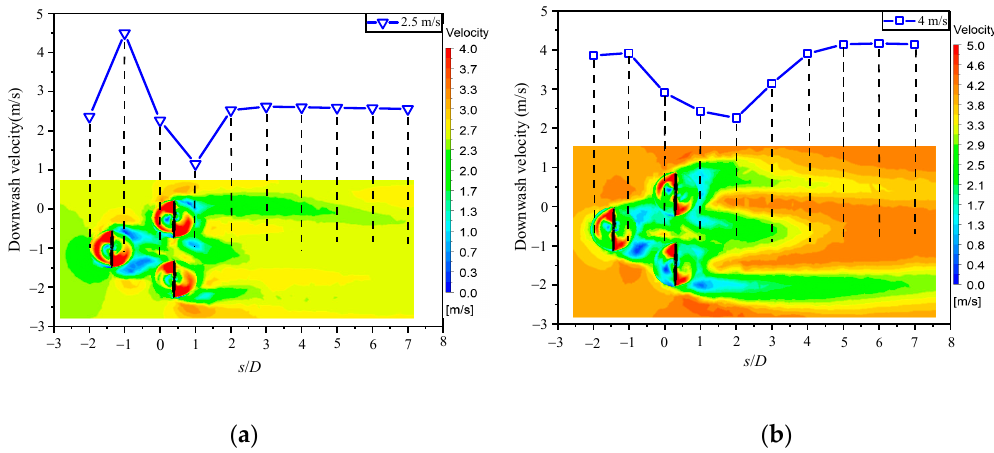
Figure 13. The velocity variation of the lower rotor plane: ( a ) 2.5 m / s; ( b ) 4 m /